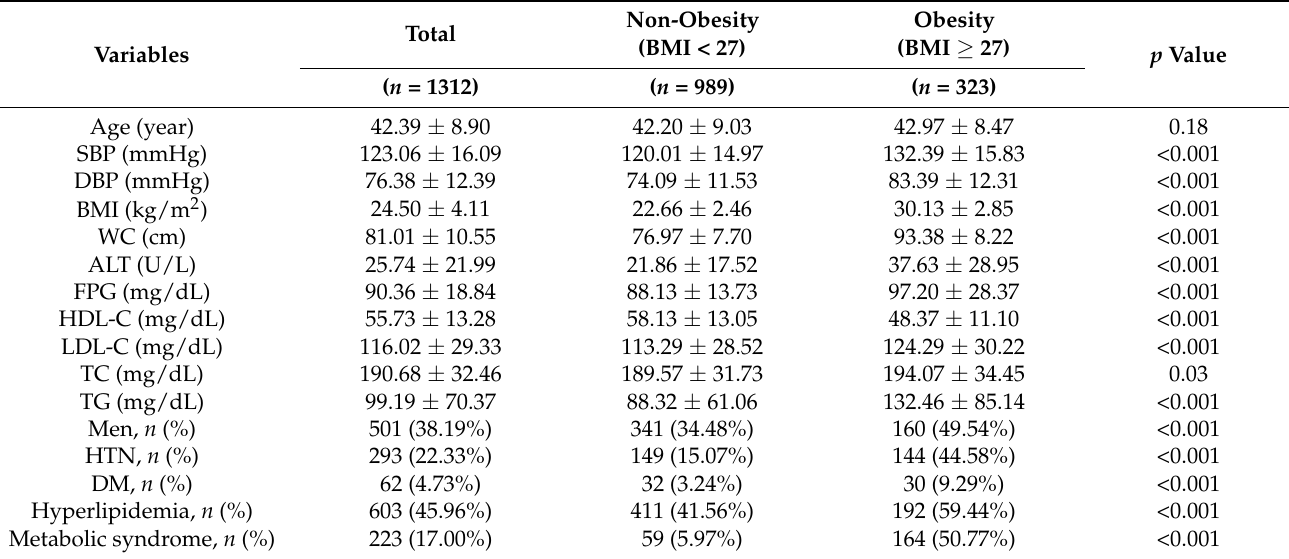
Table 1. Clinical characteristics between obesity and non-obesity group among the study